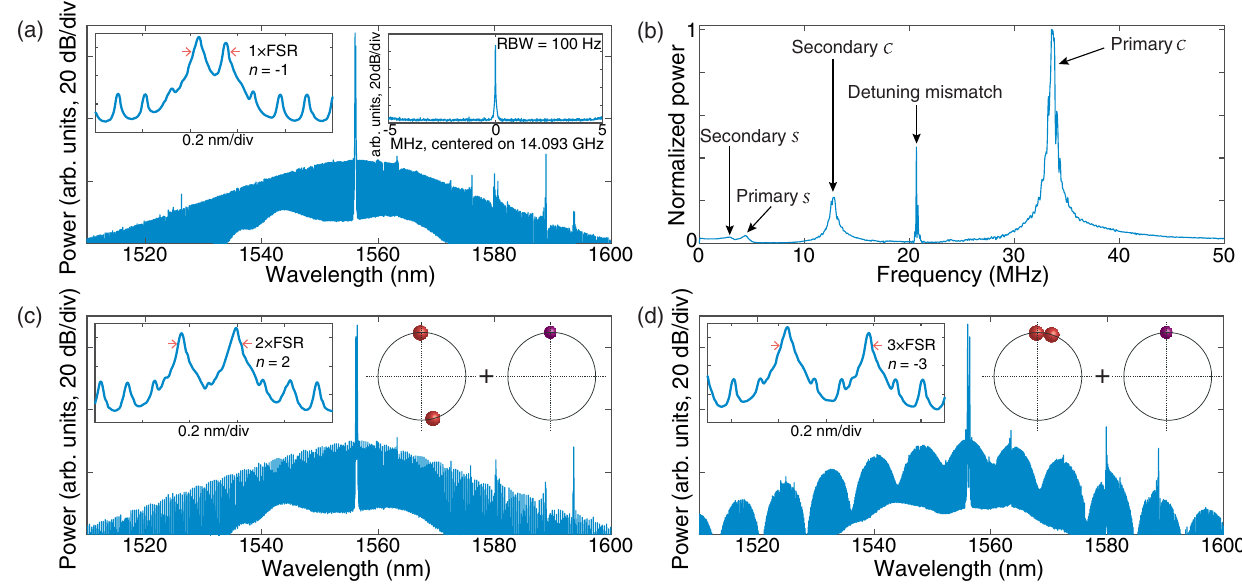
FIG. 2. Observation of dual-pumped composite solitons. (a) Optical spectrum of a composite soliton with n ¼ − 1 . The inset on the left shows the central part of the spectrum. The inset on the right shows the measured single repetition rate of the composite solitons. The resolution bandwidth (RBW) of the measurement is 100 Hz. (b) The measured response of pump probing by vector network analyzer. Two pairs of “ S resonance ” and “ C resonance ” are indicated. (c),(d) Two examples of generated composite soliton spectra corresponding to the pumping schemes shown in the left-hand insets with n ¼ 2 and n ¼ − 3 , respectively. The qualitative illustrations of constituent primary and secondary soliton patterns are exhibited in the right-hand insets,